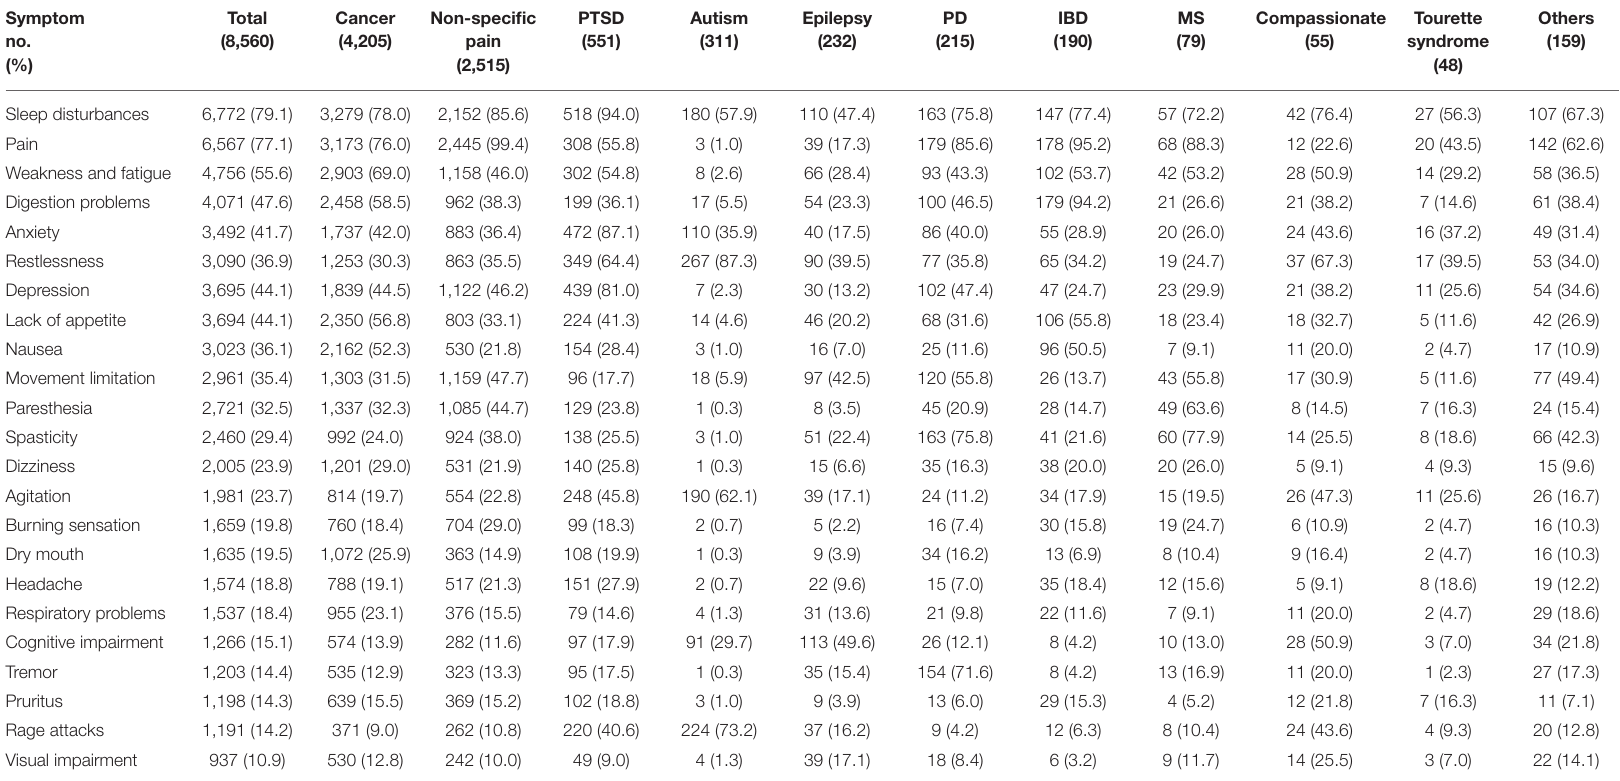
TABLE 2 | Symptoms prevalence at intake. Symptom